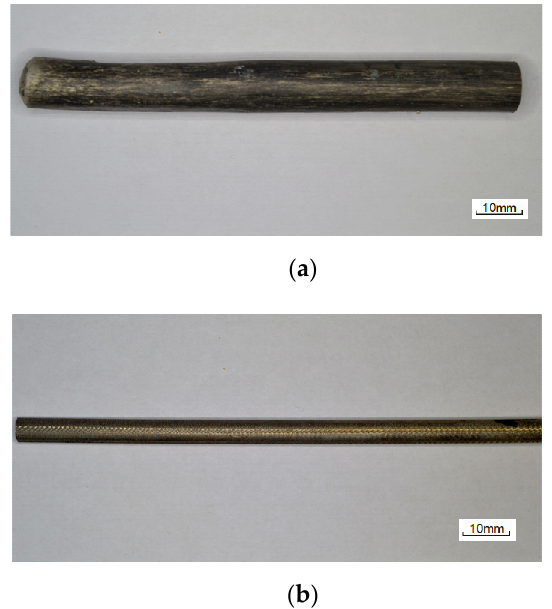
◦ C ( a ) and KoBo-extrusion ( b